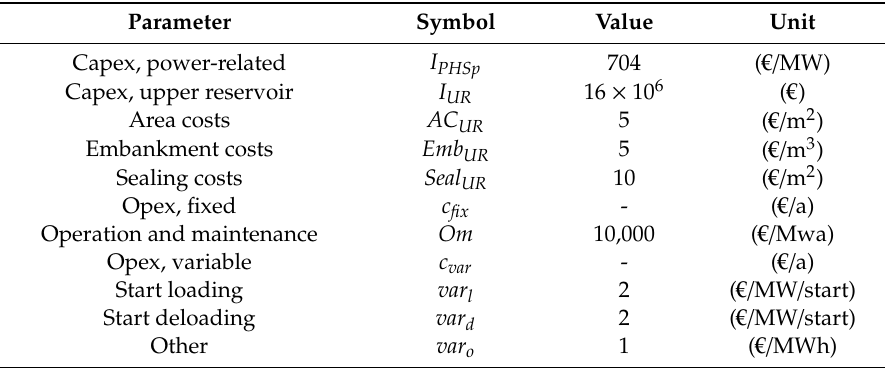
Table 4. Cost-related parameter values assumed.